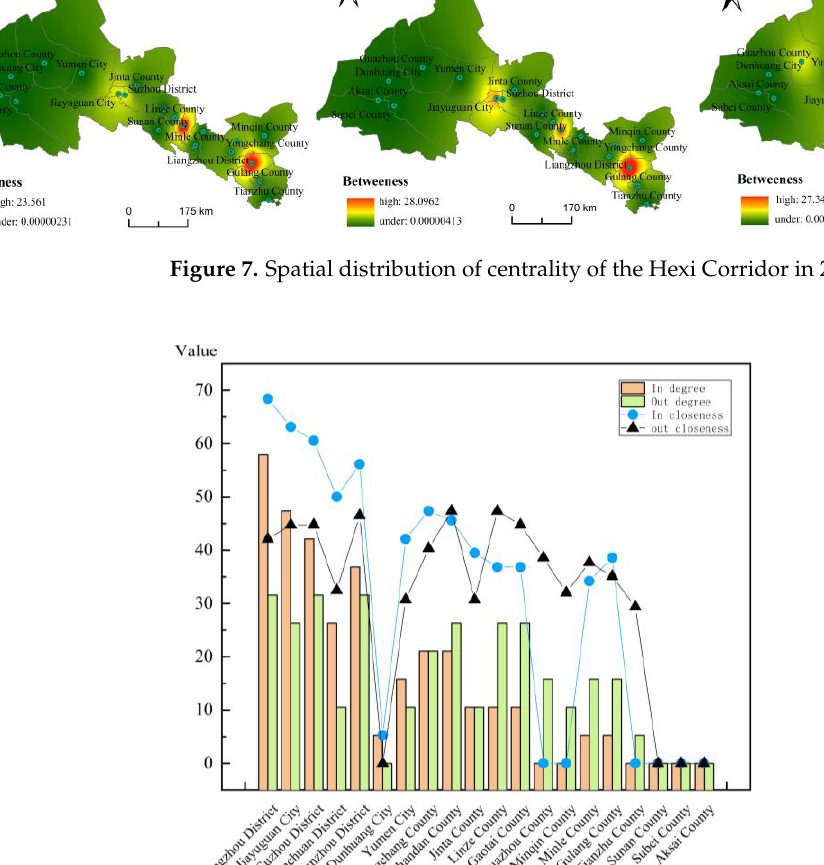
Figure 7. Spatial distribution of centrality of the Hexi Corridor in 2000, 2010, and 2020.